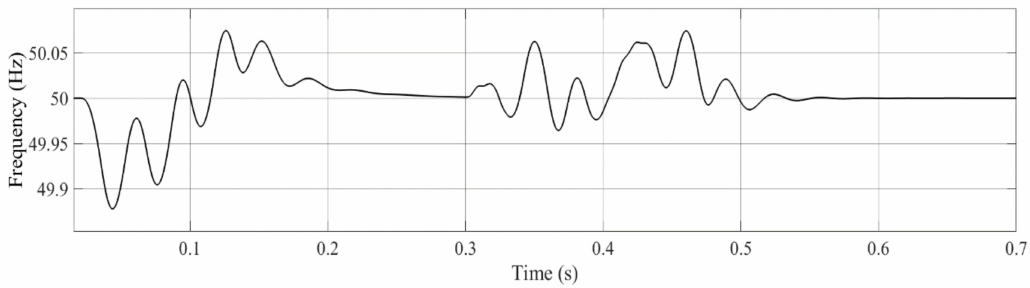
Figure 5. The potential self-restoration function for voltage and frequency in i-droop mode.